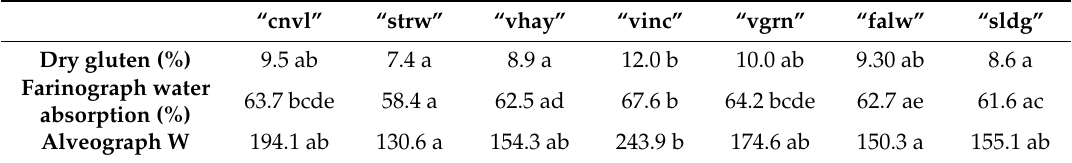
Table 3. Summary of results of quality characteristics of flour coming from wheat grain harvested in 2008. Mean values followed by the same letter were not significantly different at p < 0.05. “cnvl” “strw” “vhay” “vinc” “vgrn” “falw”